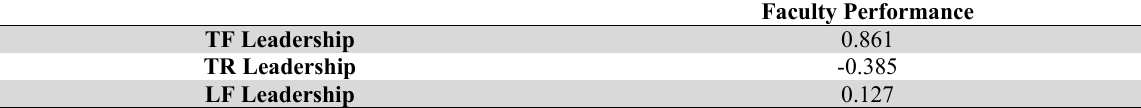
Faculty Performance